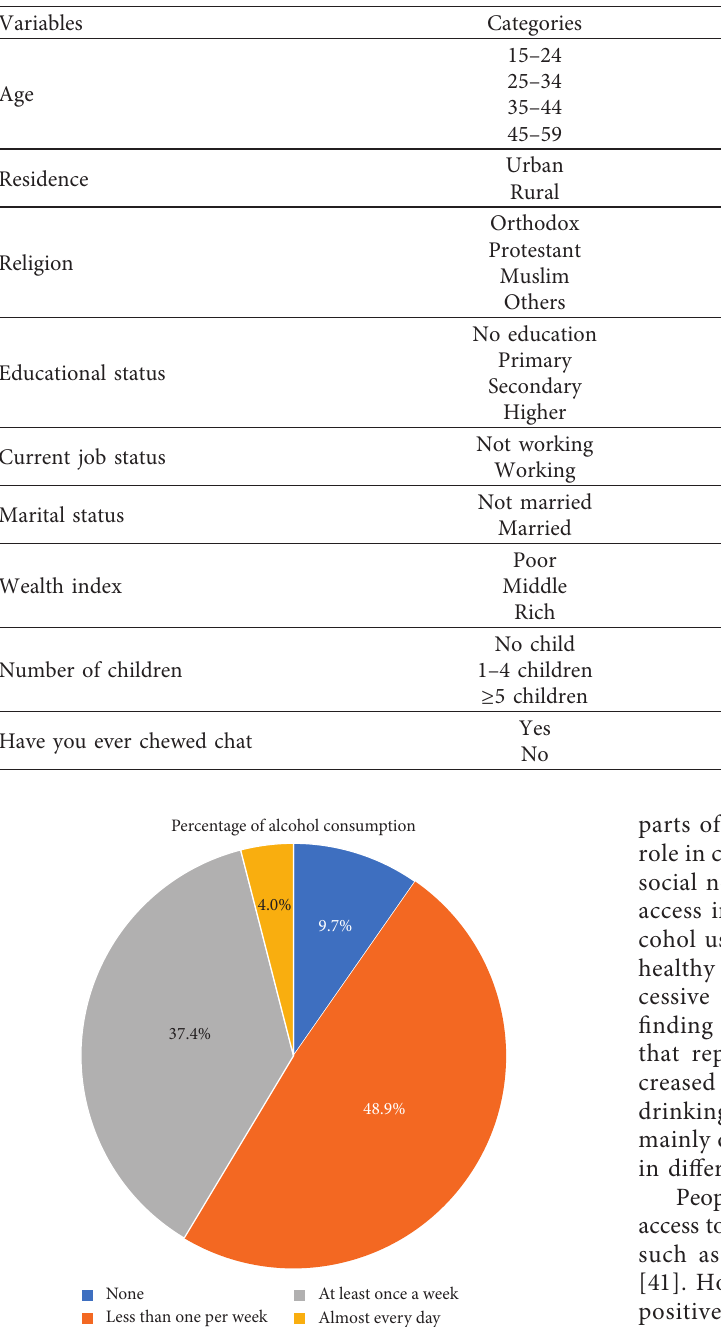
Table 1: Sociodemographic characteristics of the study sample ( N � 12,688).